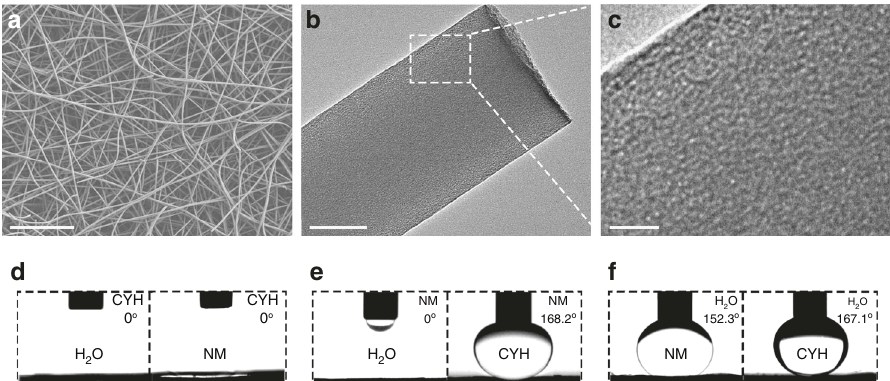
Fig. 1 Nanostructure and infused-liquid-switchable wetting behavior of STPNMs. a SEM image of STPNMs, showing the entangled uniform fi bers with a diameter of 200 – 300 nm. b , c TEM images of STPNMs exhibit the worm-like mesopores with orientational randomization in the fi bers. Scale bars , a : 10 μ m; b : 100 nm; c : 20 nm. d – f The switchable wetting behavior of STPNMs when immersed in cyclohexane, nitromethane and water, respectively, and named as liquid-LII. 1 µ l of liquid droplet is used as indicator for all of the liquids. d The CYH-LII is lyophilic for water and NM. e The NM-LII is lyophilic for water but lyophobic for CYH. f The water-LII is lyophobic for both NM and